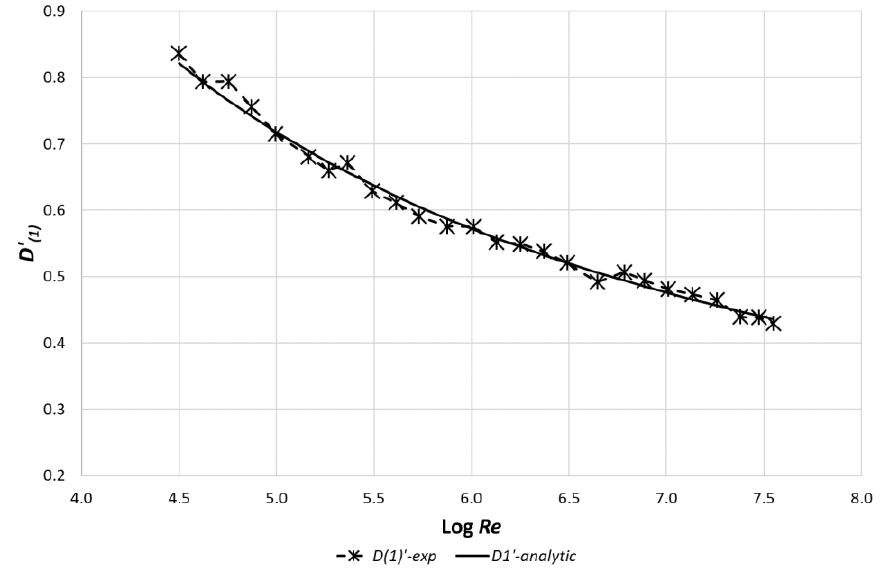
Figure 18. The comparison of the analytical expressions for D’ (1) with the experimental data.